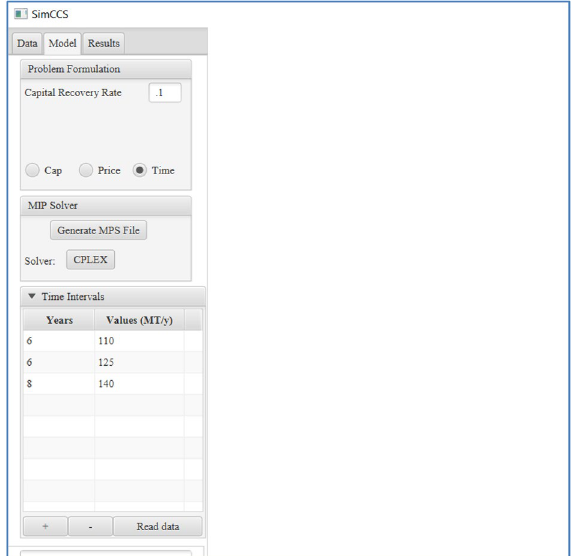
Figure 2. Time mode in the Model panel for SimCCS 3.0